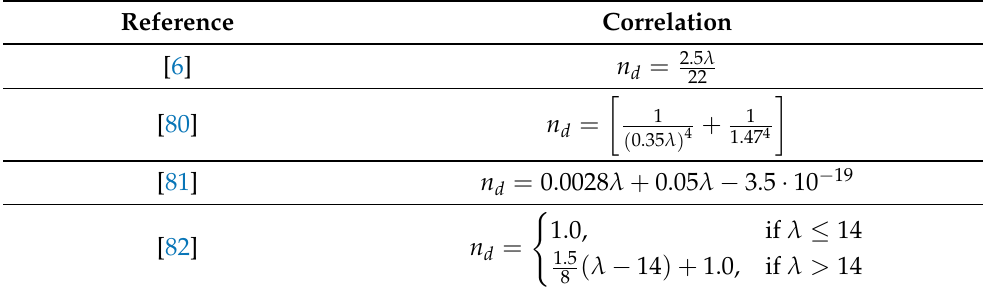
Table 11. Correlations for the electro-osmotic drag coefficient n d